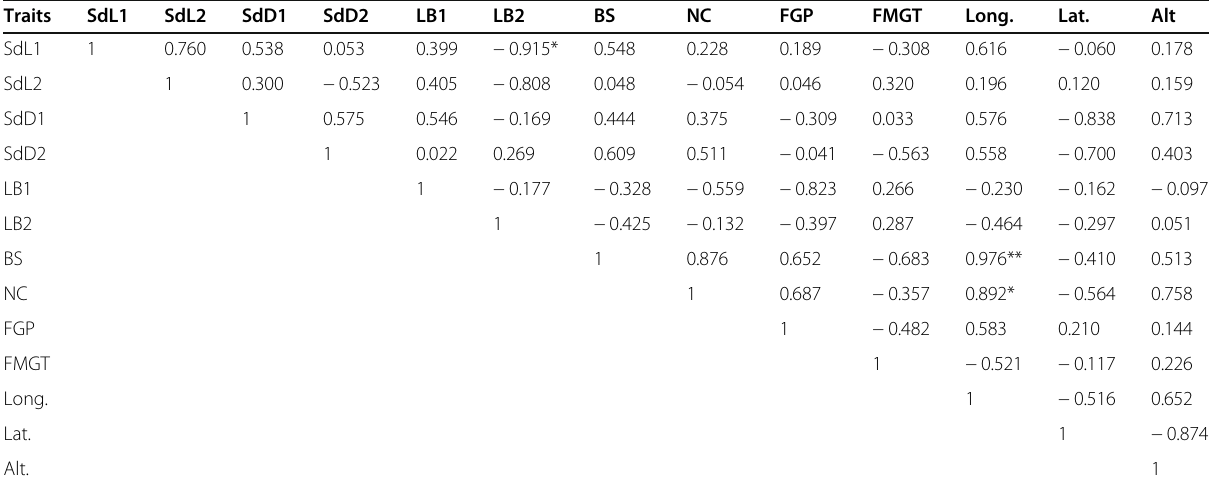
FGP field germination percentage, FMGT field mean germination time, Long . longitude, Lat . latitude, Alt . altitude. For other abbreviations, please see Table 2. * and ** stating significant differences at 0.05 and 0.01 levels,